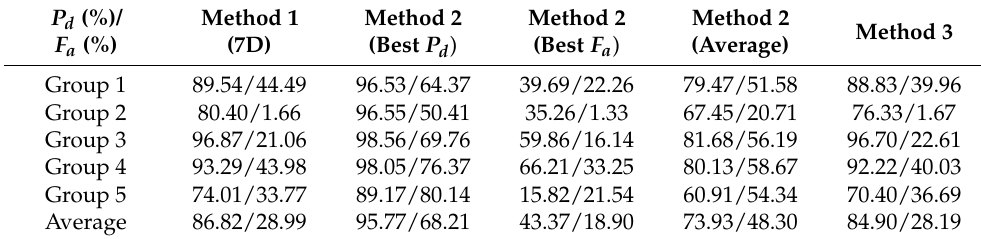
Figure 9. Diagram of the segmentation result images. Note that the incident angles of light are marked on the original images and the result images of Method 2. Table 4. Probability and false alarm rate of segmentation results obtained by the three methods.